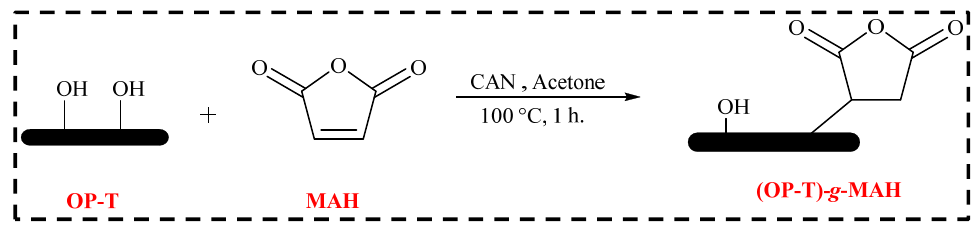
Scheme 2. Schematic of grafting reaction of MAH onto OP-T chains in the presence of CAN.